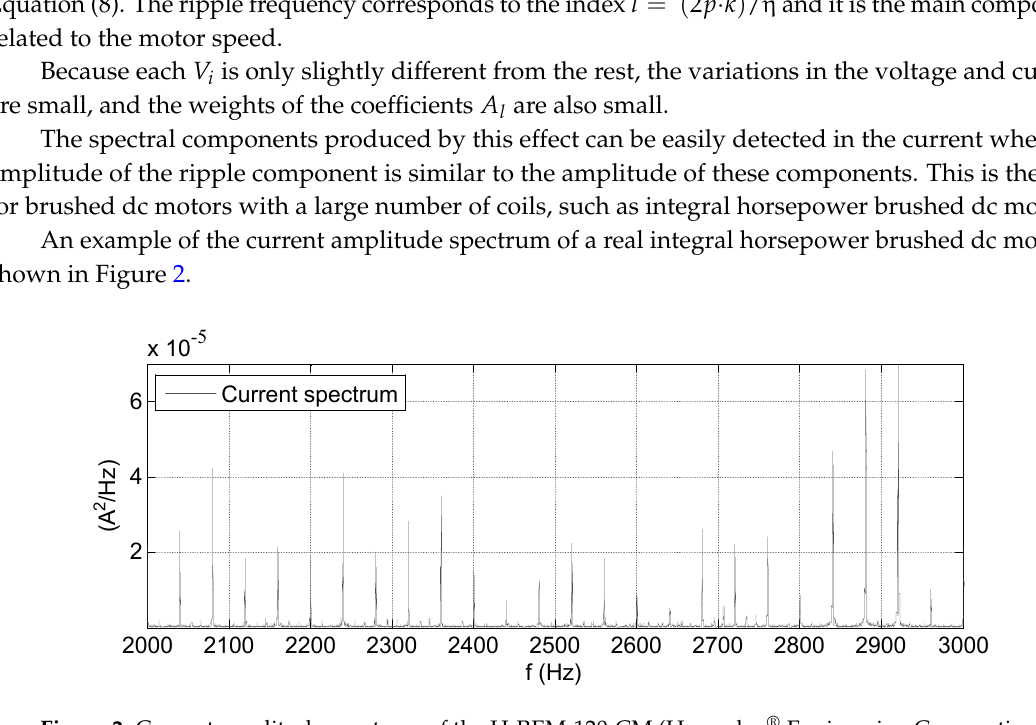
Figure 2. Current amplitude spectrum of the H ‐ REM ‐ 120 ‐ CM (Hampden ® Engineering Corporation, East Longmeadow, MA, USA) integral horsepower brushed dc motor with shunt excitation configuration while rotating at 2400 rpm.